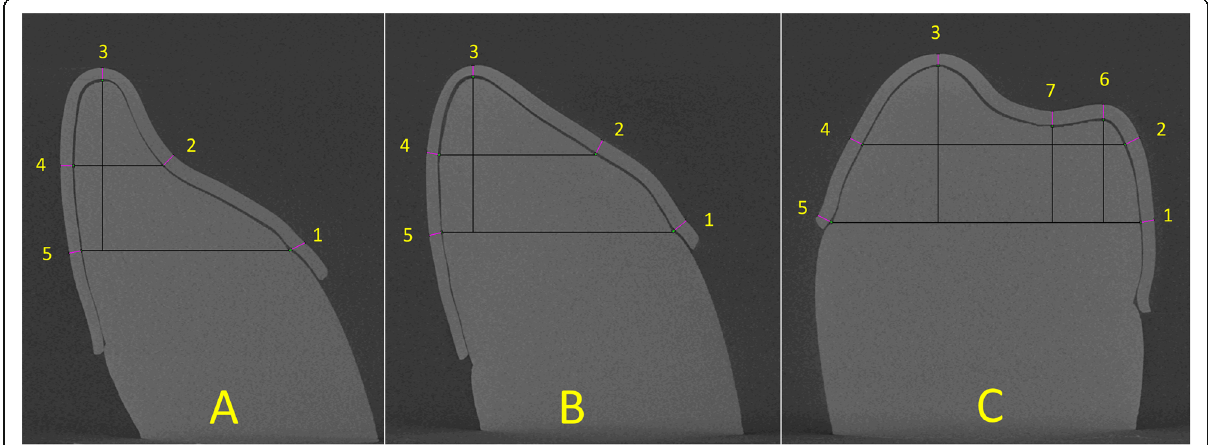
Fig. 4 Identification of 2D points on construction grid for incisor ( a ), canine ( b ) and first molar ( c ). Eight points were identified: 1, palatal gingival; 2, midway point between 1 and 3; 3, incisal edge; 4, midway point between 3 and 5; 5, vestibular gingival; 6, vestibular cusp; 7, palatal cusp;